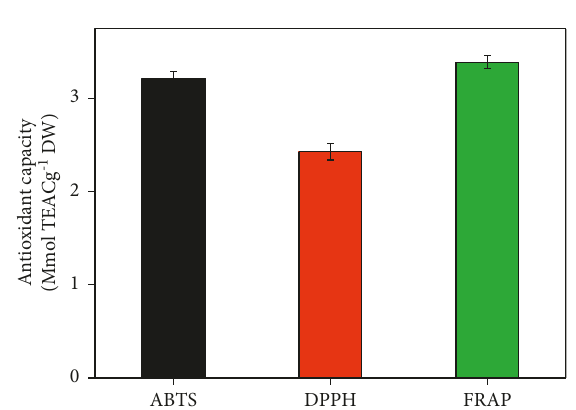
Figure 2: Anti-oxidant capacity in the chia